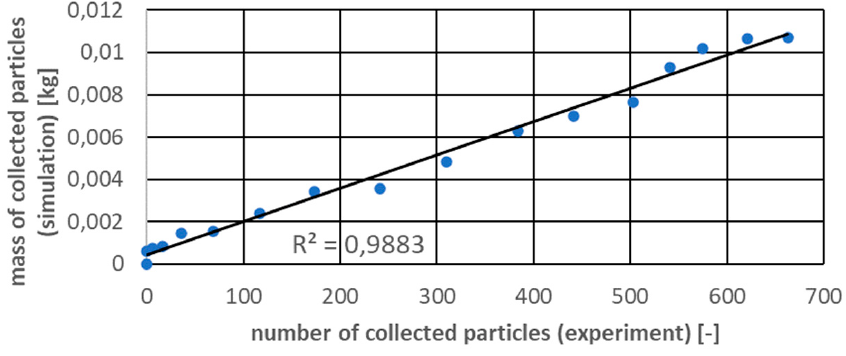
Figure 14. Correlation between chosen parameters.